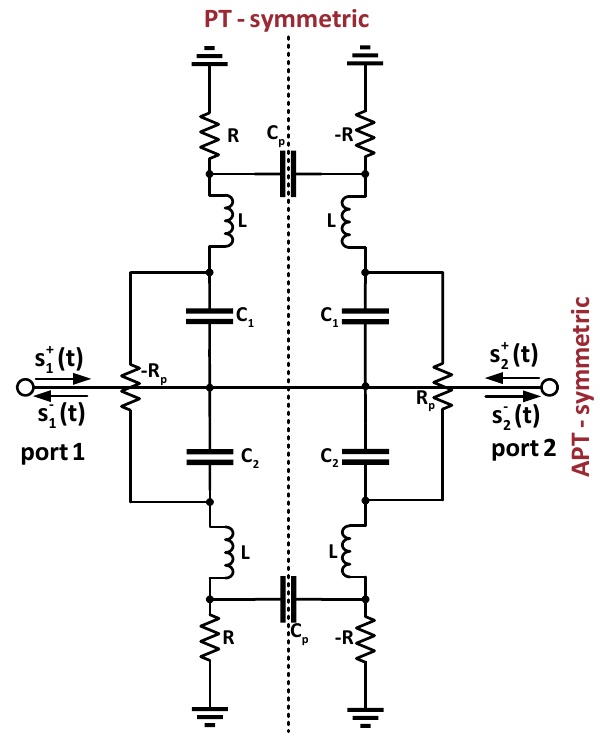
Figure 4: Realistic layout of a PT-APT-symmetric circuit. A pair of PT-symmetric LC resonators with inductance L , capacitance C 1 , and positive(negative)resistance R ( − R )arecoupledbyacapacitance C p .